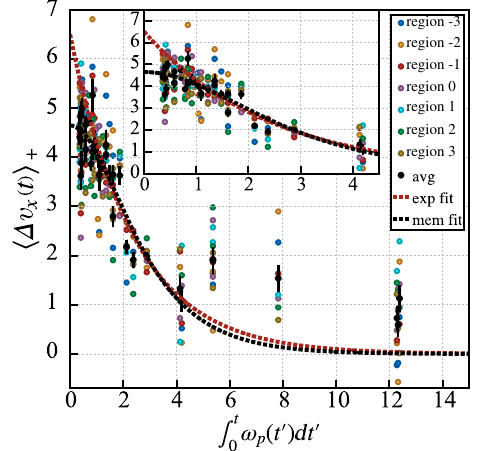
FIG. 8. Evolution of average velocity of pumped spectra across all regions for the plasma described in Fig. 6. The black circles represent the mean value for each time point. The inset represents a closeup view of the same data over a scaled time ranging from 0 to 4.5 to highlight the nonexponential decay at early all regions at each time. The error bars are the statistical, one-standard-deviation uncertainties of the mean values, which we use in the main article to calculate the uncer- = h Δ v 0 Þi tainties in h Δ v x ð t Þi . The fits to the exponen- x ð þ þ tial function (using data in the range 0 . 8 < ω p t < 4 ) and to the memory kernel (using data in the range 0 < ω p t < 4 ) are also shown for reference.